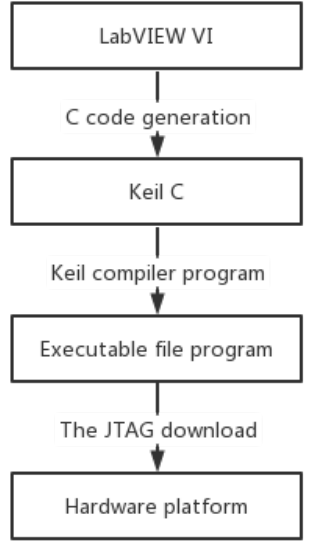
Figure 16. Development process of RAM by LabVIEW.